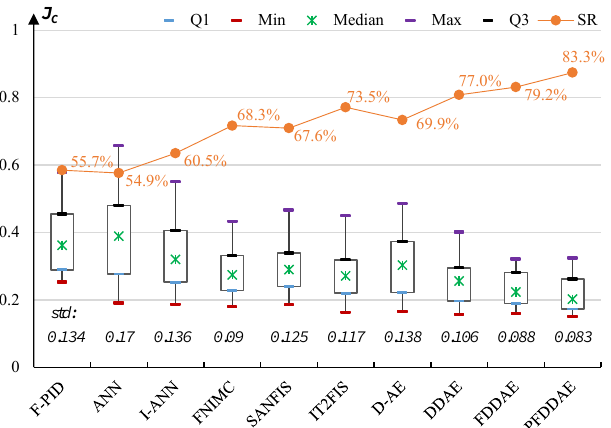
Figure 9. The performance (in terms of regression error and success rate) of the comparative models for cyborg flight